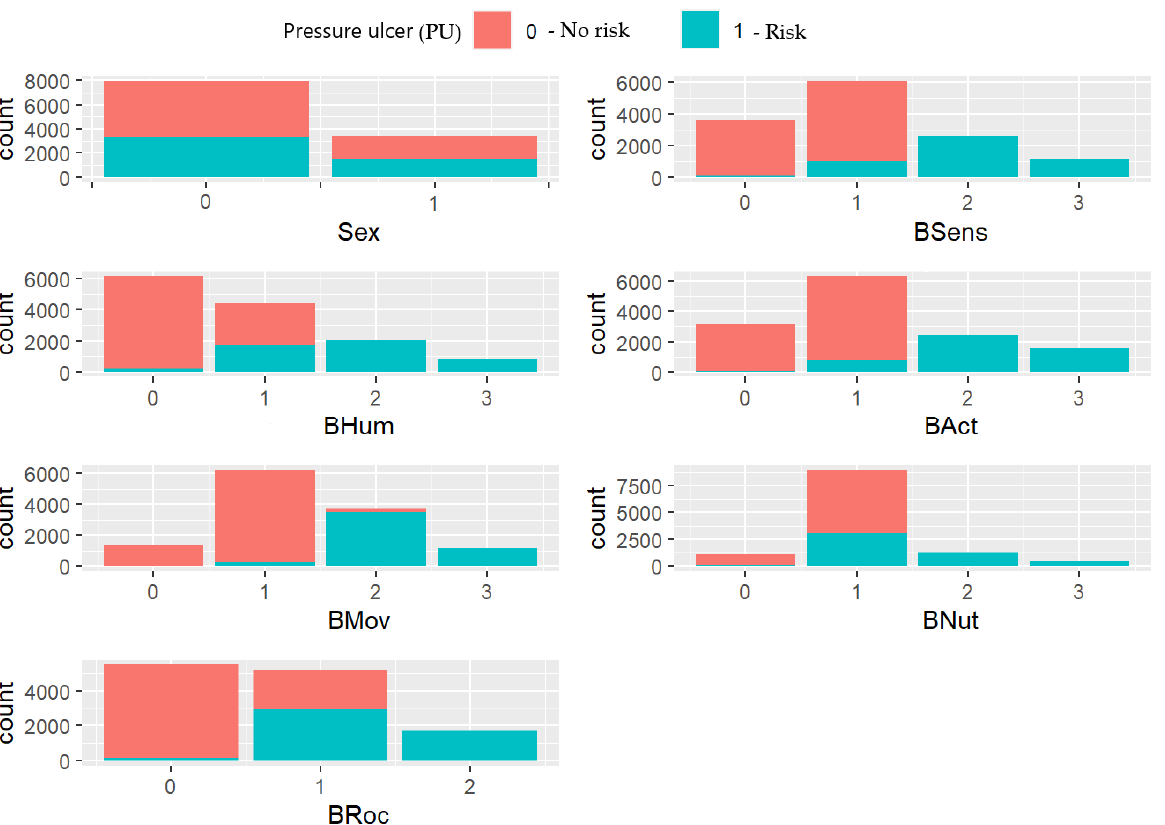
The overlap histograms for the classification of a patient at risk or not of suffering from pressure ulcer, based on sex and each one of the subscales independently, are dis-played in Figure 1. Activity (BAct) and mobility (BMov) subscales seem to be adequate as indepen- dent classifiers. This is reflected in their histograms, because the colors that correspond to each level of PU risk are well separated for the different values of these subscales.